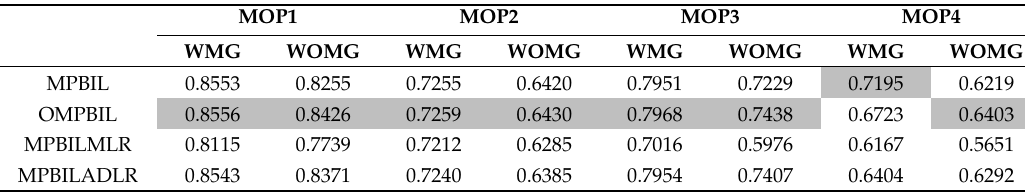
Table 1. Performance comparison based on hypervolume (HV) 1 .